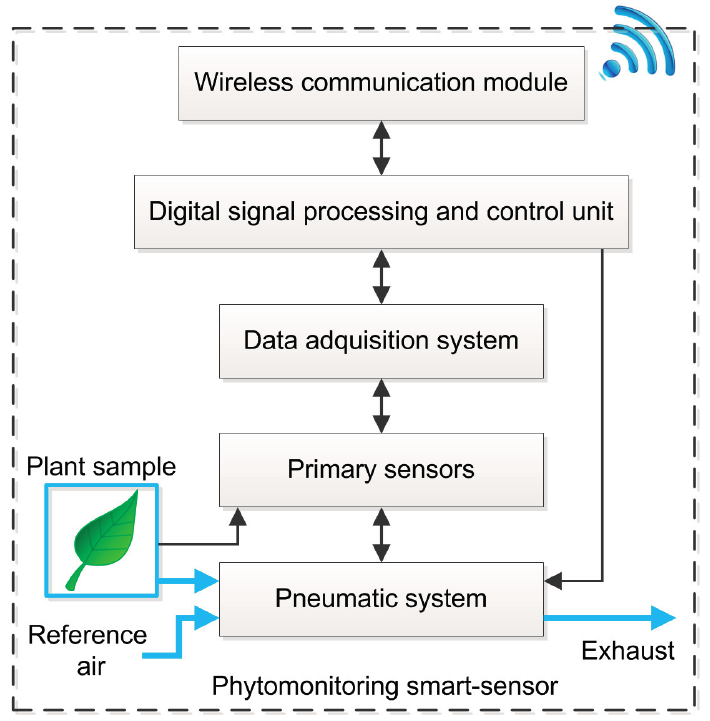
Figure 1. Block diagram of the phytomonitoring smart-sensor.